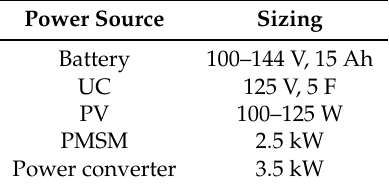
Table 8. Considerations for the simulation of the multiple-input converter.